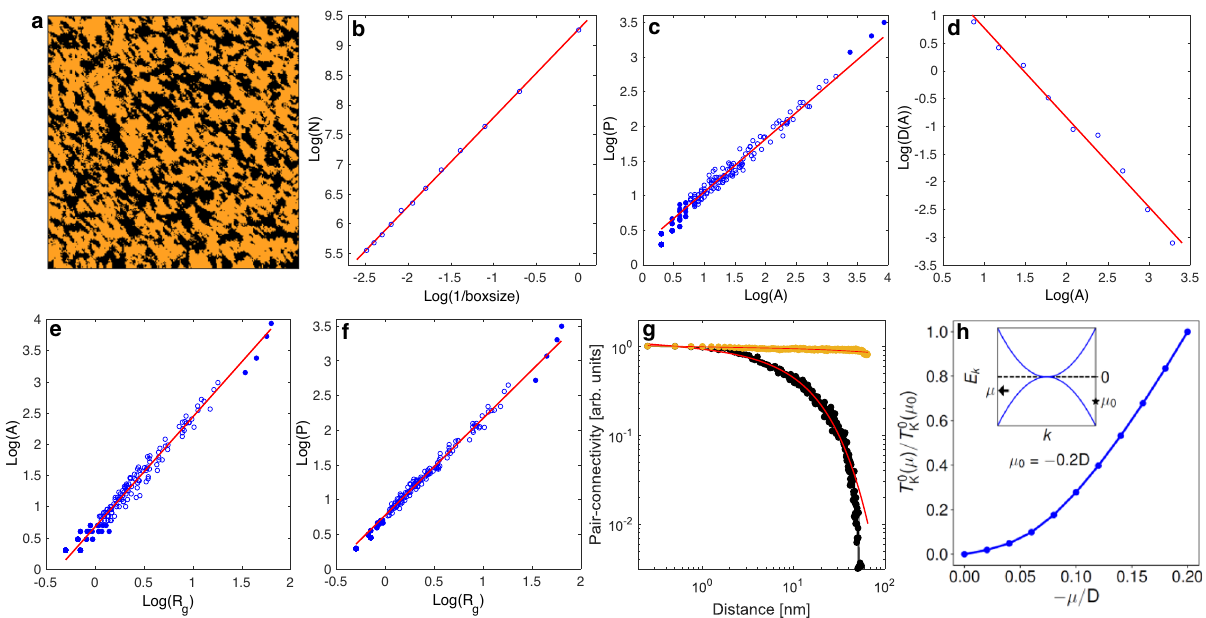
Fig. 4 Fractal domain structure of the nanoscale patterns. a K -means cluster map (65 nm) forced using two clusters. The black clusters were used for the fractal analysis. The corresponding STM conductance map can be found in Supplementary Note 11. The data are taken at 33 K. b The fractal dimension analysis using a box-counting method resulting in fractal dimension D = 1.49 ± 0.02. The data points are fi tted by the least-square method to the power law (cid:1) (cid:3) D where N denotes the number of boxes of clusters. c Perimeter versus area of the clusters. Filled circles are excluded from the fi t. Using P = N ¼ 1 boxsize A D /2 gives a fractal dimension value of D = 1.53 ± 0.03; this corresponds well with the box-counting method. d Cluster area distribution with logarithmic ffiffiffiffiffiffiffiffiffiffiffiffiffiffiffiffiffiffiffiffiffiffiffi (cid:5) (cid:6)q r (cid:2) r h ið Þ 2 binning, giving a Fisher exponent τ = 1.62 ± 0.16. e Utilizing the radius of gyration for each cluster, R g ¼ , where r is summed over all points in that cluster, the equation A ¼ R d v g gives a value of d v = 1.76 ± 0.06. f Similarly using P ¼ R d h gives a value of d h = 1.39 ± 0.03. g Pair-connectivity function g extracted from the black (black) and orange (orange) regions. The lines are fi t to the function y ¼ r (cid:2) η e (cid:2) r = χ , where η and χ are the scaling exponent and the ¼ (cid:2) 0 : 2 D Þ , as a function of chemical potential μ in the case of quadratic touching conduction- correlation length. h Kondo scale T 0 K ð μ Þ normalized by T 0 K ð μ 0 electron bands. The Kondo scale is seen to be highly sensitive to slight variations of μ near the node (Fermi energy) in the band structure. The inset illustrates the two conduction-electron bands, each with a quadratic dispersion, touching at the Fermi